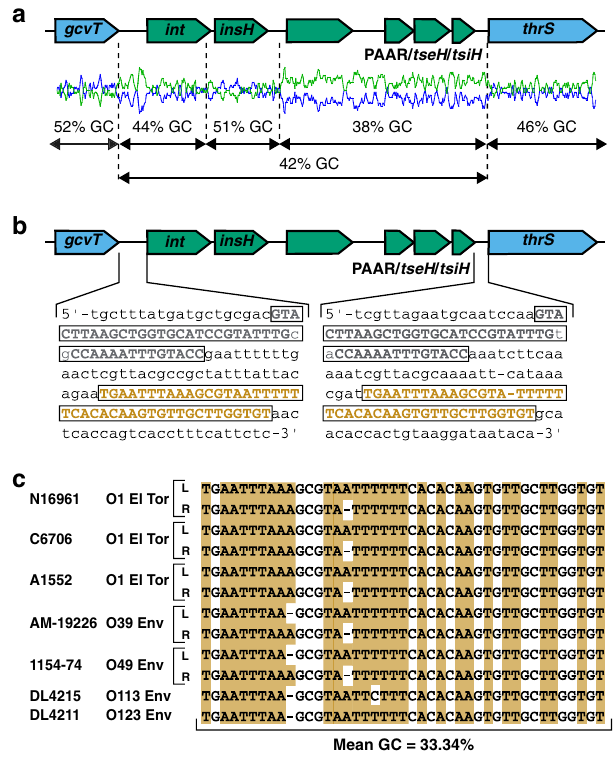
Fig. 1 T6SS Aux3 module is fl anked by conserved phage-like att sites. a Local GC content of the N16961 Aux3 cluster and the fl anking regions. Aux3 genes are shown in green and the genomic fl anks in blue. GC content (blue line) and AT content (green line) are shown. b Intergenic regions fl anking Aux3 contain repeated sequences. Direct repeat sequences are boxed and shown in grey (repeat 1) and orange (repeat 2 or attL_Aux3/ attR_Aux3 ). c Alignment of phage-like att sites from Aux3-encoding strains (N16961, C6706, A1552, AM-19226 and 1154-74) and Aux3-naïve environmental strains (DL4215 and DL4211). Both attL_Aux3 (top) and attR_Aux3 (bottom) are represented for Aux3-encoding strains, and attB_Aux3 is shown for each naïve strain. The average GC content is shown, as att sites are typically AT-rich